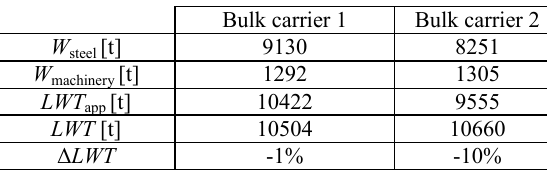
Table 2. Estimation of group